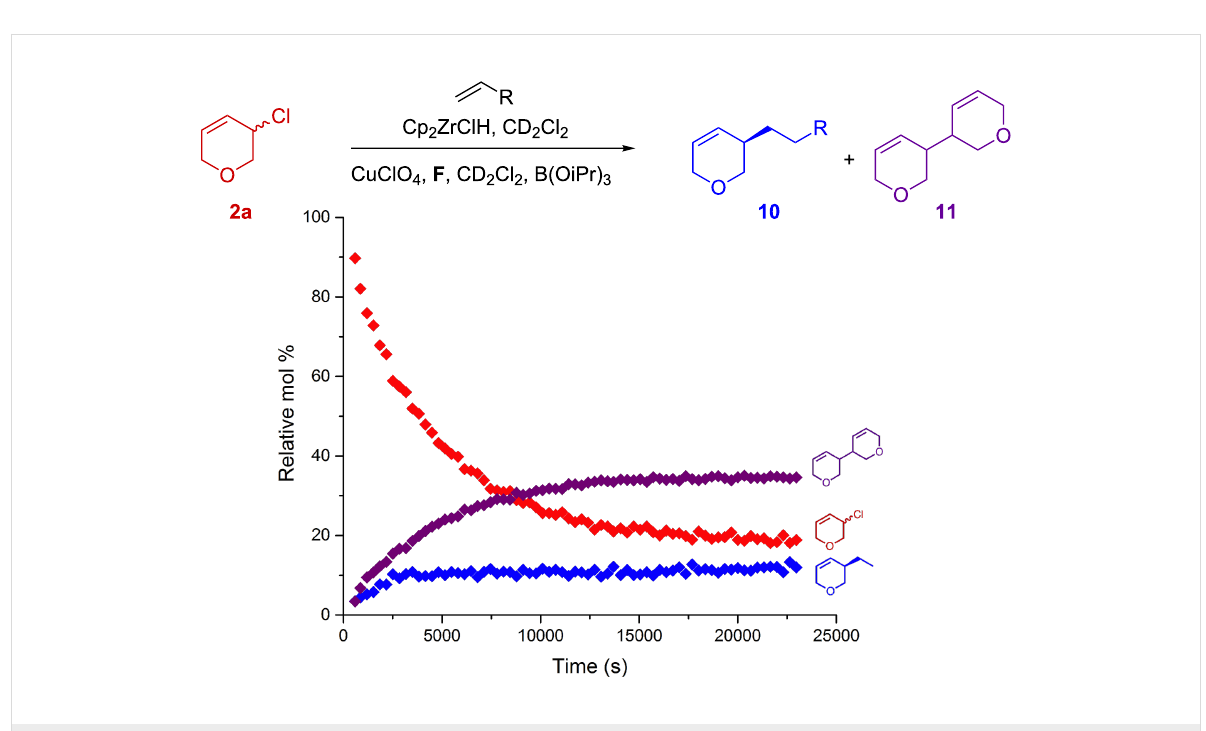
both the conditions and leaving groups differ in the two reac- tions it is not clear why 2a , but not 2d , dimerizes. 11 can exists as 3 isomers, a meso compound and two enantiomers. Upon comparison to literature data [44], we concluded that we form a